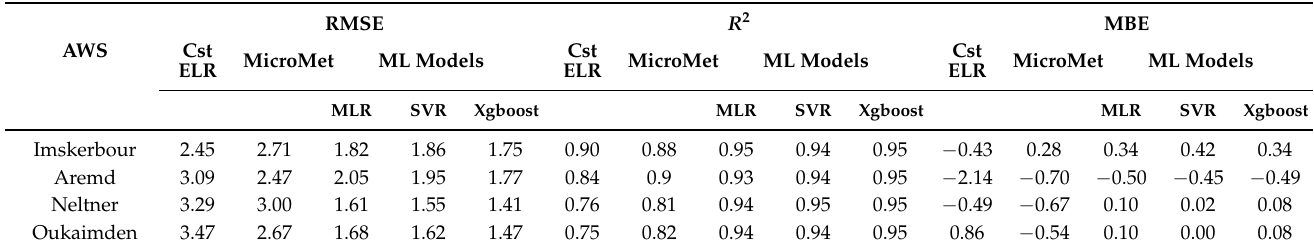
Table 4. Downscaling performance metrics by station and